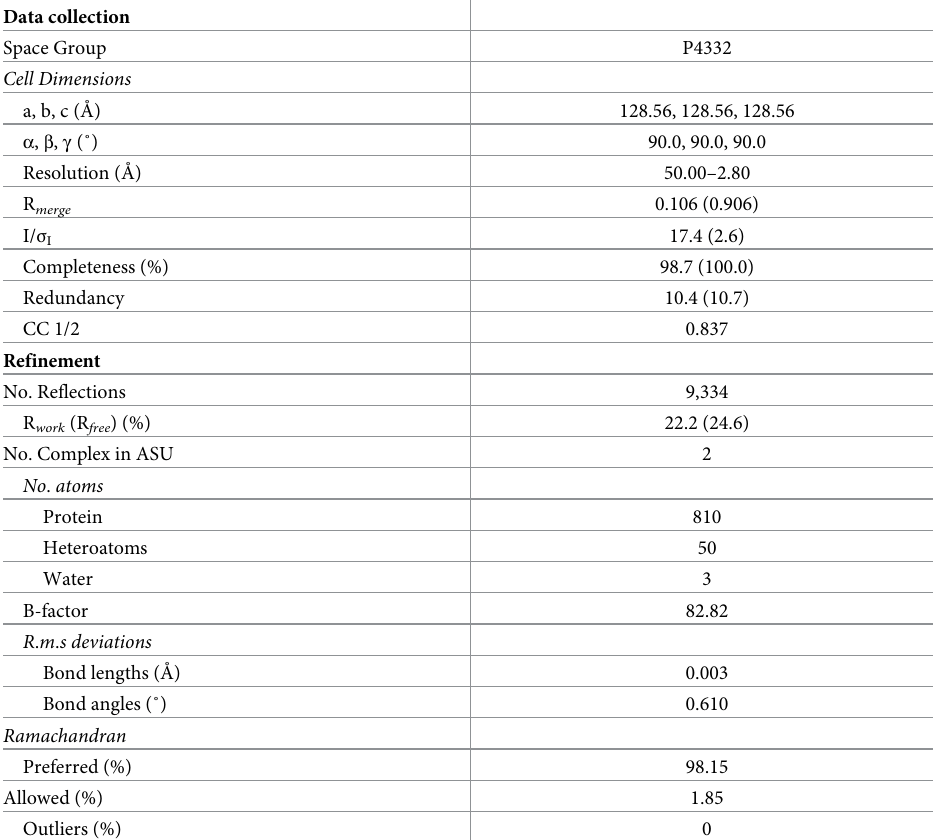
Table 1. Structural features of